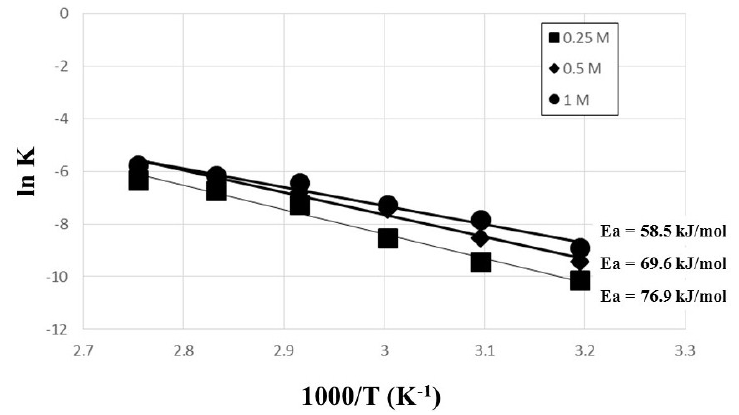
Figure 7. Arrhenius plots. (1 kmol m −3 HCl; 0.25 kmol m −3 –1 kmol m −3 Fe 3+ ; 400 rpm agitation speed; 10% pulp density; 40 °C–90 °C